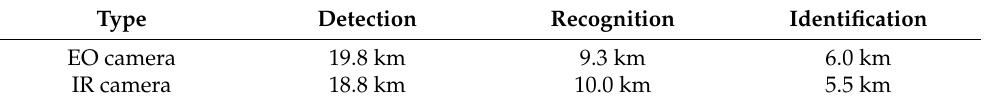
Table 1. DRI characteristics of the